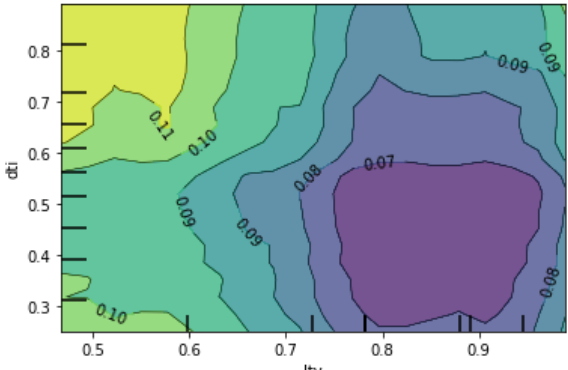
Figure 7. PDP for changes in original LTV (ltv) and original DTI (dti) in the RF model